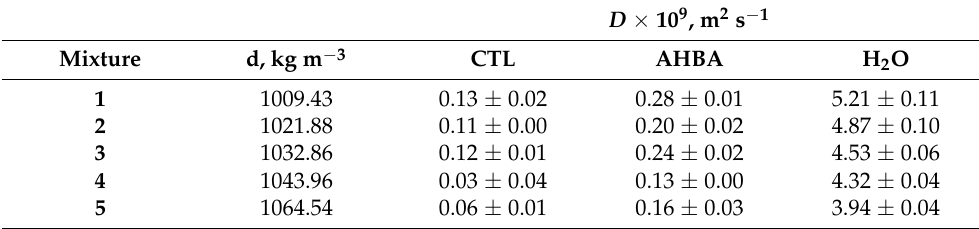
Table 2. Density (d) and self-diffusion coefficients (D) of the studied pre-polymerization mixtures.